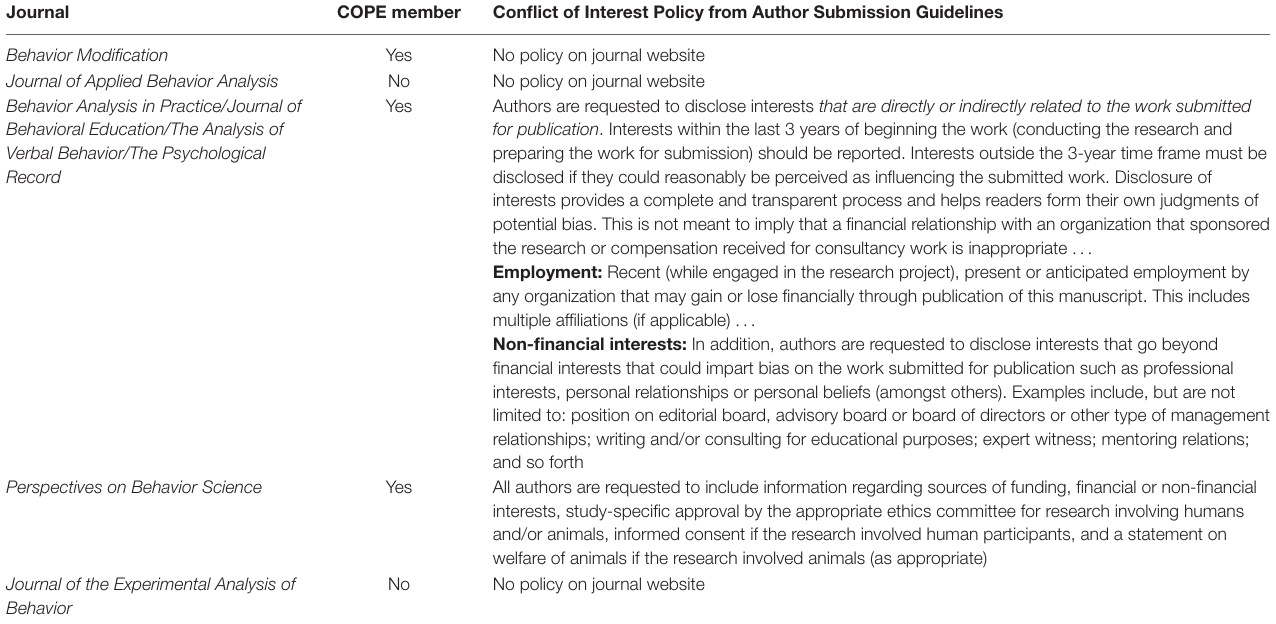
TABLE 1 | Author Submission Guidelines Relevant to Conflict of Interest